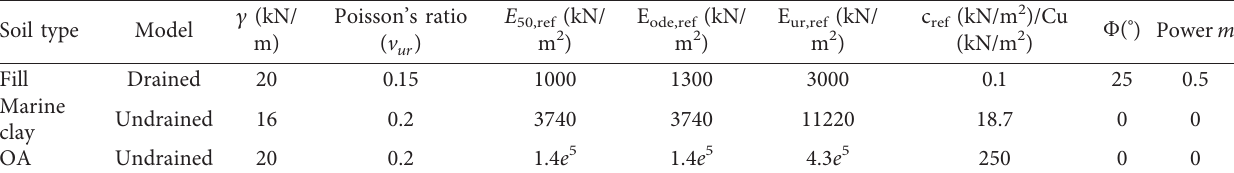
Table 2: HS soil parameters based on the back analysis of similar geotechnical conditions [15].